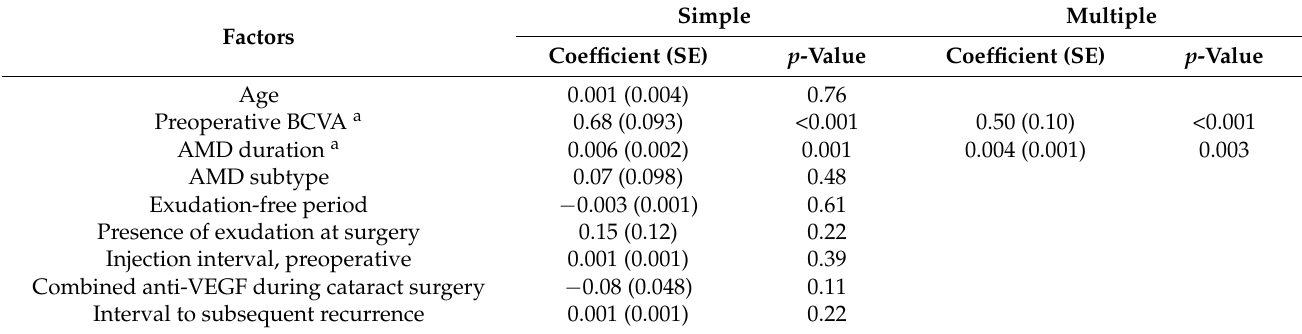
Table 2. Analysis of prognostic factors associated with postoperative BCVA (logMAR) at one